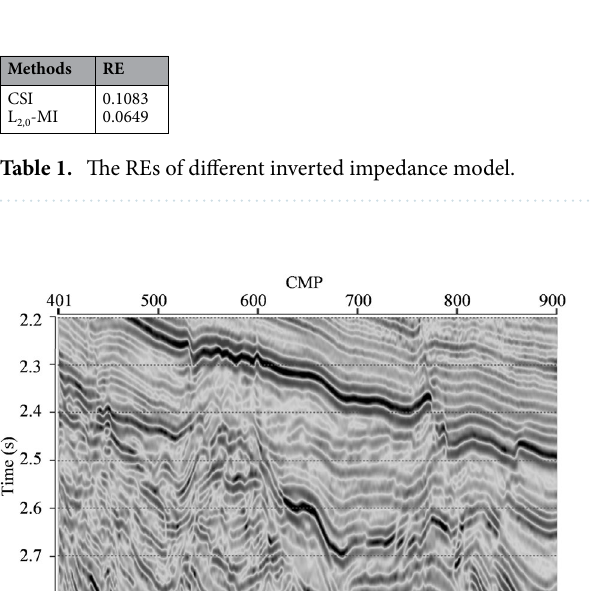
Figure 3. ( a ) The residuals between predicted data by L 2,0 -MI and noise-tainted synthetic seismic data. ( b ) The residuals between predicted data by CSI and noise-tainted synthetic seismic data.